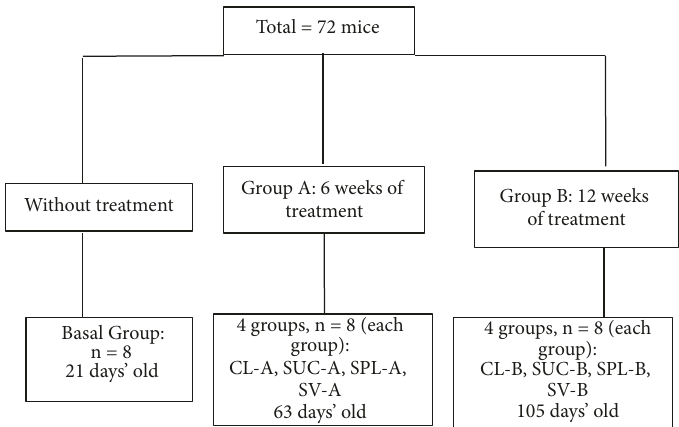
Figure 1: Distribution of study groups by time and type of treatment. CL (Control), SUC (Sucrose), SPL (Splenda (cid:2) ), and SV (Svetia (cid:2)